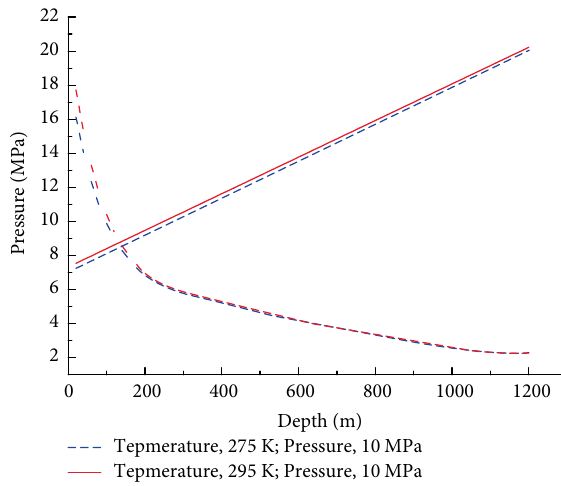
Figure 5: The annulus pressure distribution and hydrate phase equilibrium with different injection temperatures.